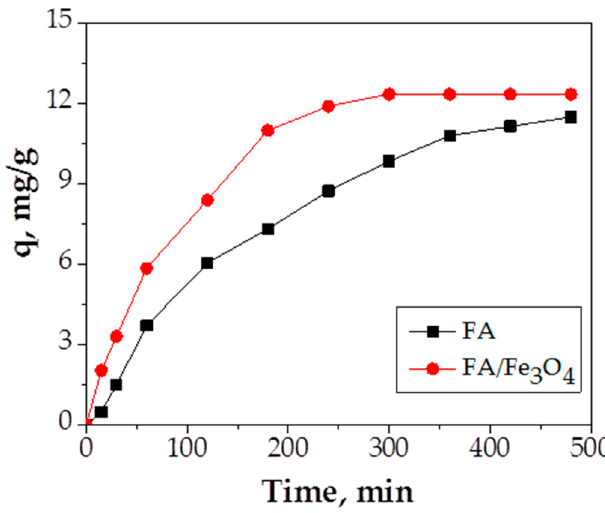
Figure 9. The effect of contact time (experimental conditions—initial pH = 5.0; adsorbent dosage = 0.2 g adsorbent/20 mL Cu (II) solution; initial metal concentration = 300 mg/L; temperature = 26 °C).